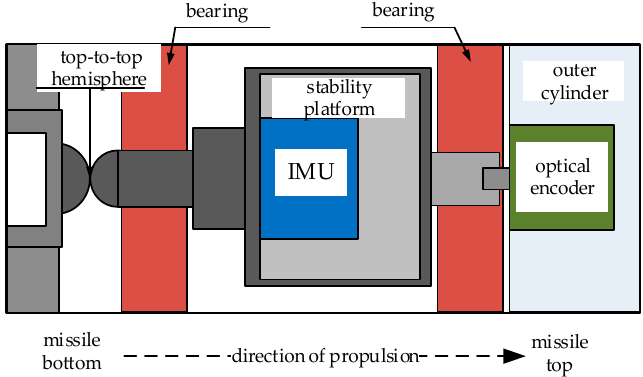
Figure 2. Arrangement of high precision Semi-Strapdown Inertial Navigation System ( SSINS).